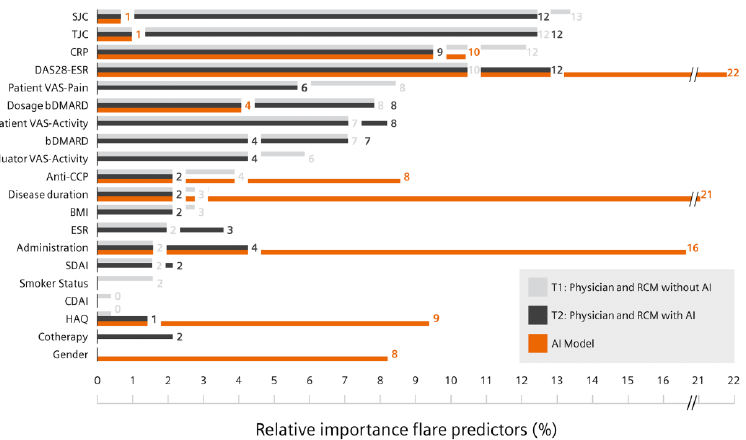
Figure 6. Relative importance of flare prediction parameters for physicians and the flare prediction tool. Relative importance of single flare predictors (y-axis) for the physicians as mean value at T1 (grey) and T2 (black) and for the flare prediction tool (orange) shown in percent (x-axis). SJC — swollen joint count; TJC — tender joint count; CRP — C-reactive protein; DAS28 — disease activity score 28 joints; ESR — erythrocyte sedimentation rate; VAS — visual analogue scale;